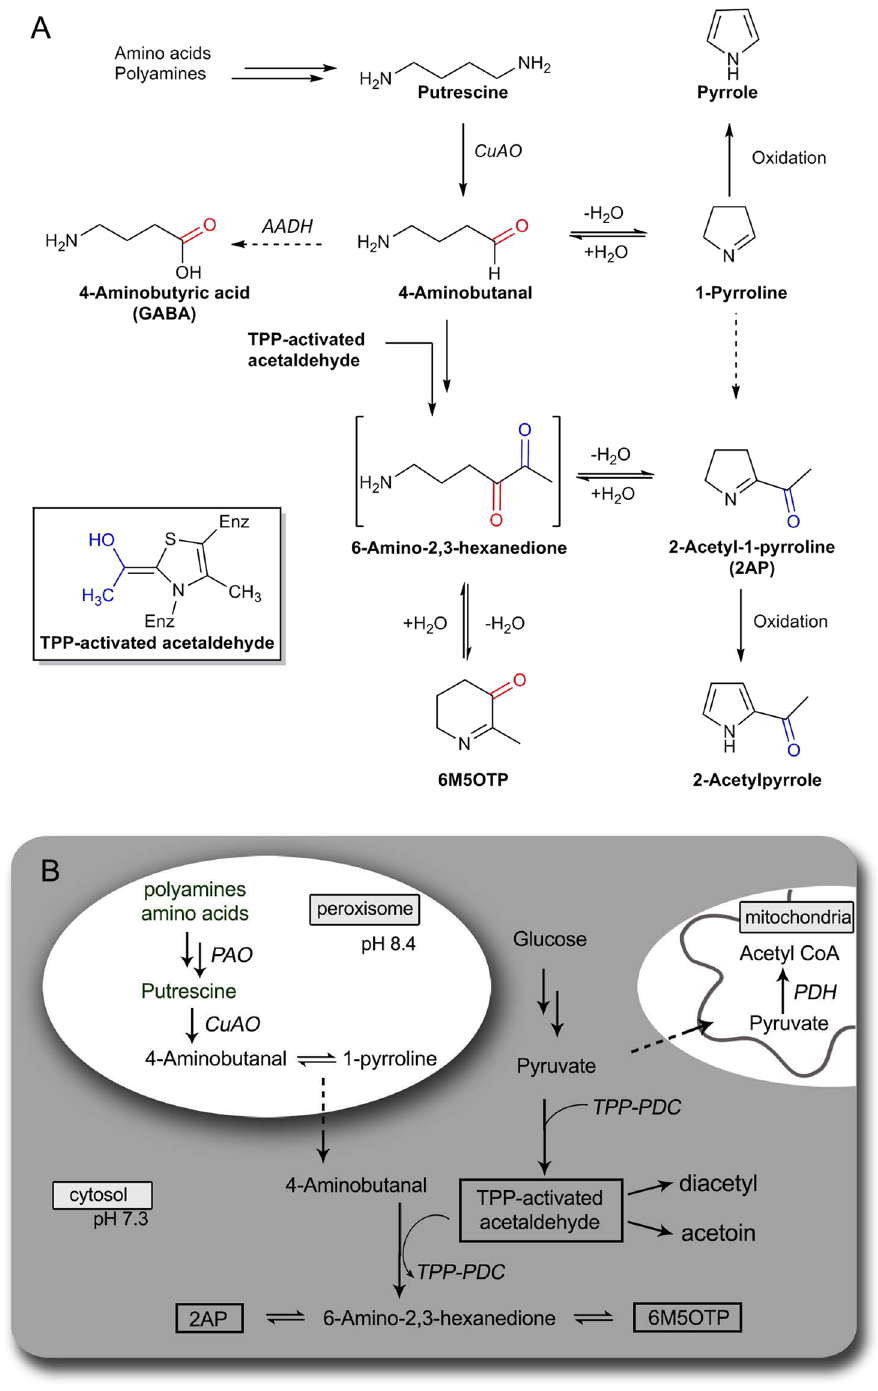
Figure 5. Putative biosynthesis of 2AP. Enzymes are in italics: CuAO – copper amine oxidase; PAO – polyamine oxidase; AADH – amino aldehyde dehydrogenase; PDC – Pyruvate decarboxylase; PDH – pyruvate dehydrogenase complex. ( A ) TPP-catalysed transfer of a C2 unit to 4-aminobutanal. The reaction with 4-aminobutanal forms an unstable diketone 6-amino2,3-hexadione, which cyclises to either 2AP or 6M5OTP. ( B ) Cellular localisation of the reactions leading to the formation of 2AP and